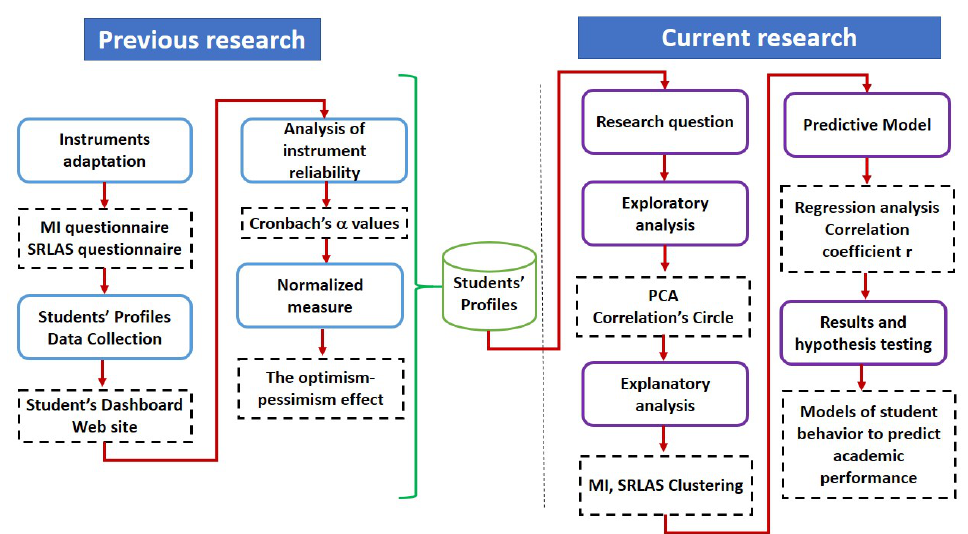
Figure 1. Overview of the